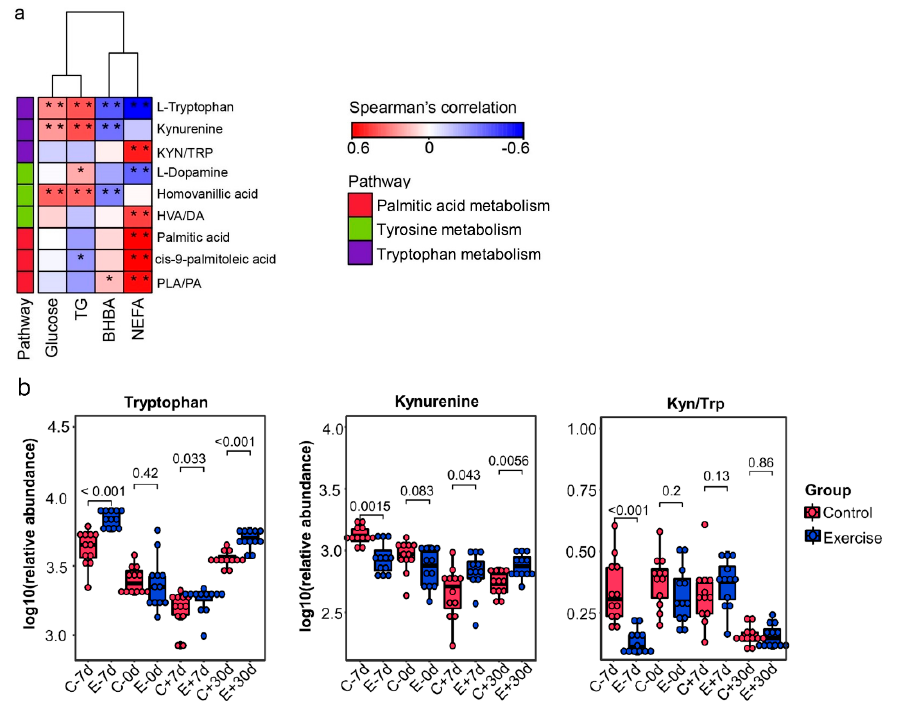
Figure 6. Spearman correlation heatmaps ( a ) for the correlations between phenotypic variables (NEFA, BHBA, TG, and glucose) and key differential metabolites in the exercise and control cows. The scale (right legend) indicates the level of positive (red) or negative (blue) correlations, and asterisks indicate significance: * p < 0.05, ** p < 0.01. PLA/PA = cis-9-palmitoleic acid to palmitic acid ratio; HVA/DA = homovanillic acid to dopamine ratio; Kyn/TRP = kynurenine to tryptophan ratio; NEFA = non-esterified fatty acids; BHBA = β -hydroxybutyric acid; TG = triglyceride. Box plots ( b ) for the relative abundance of tryptophan and kynurenine, and Kyn/Trp in the exercise and control cows at –7 d, 0 d, +7 d, and +30 d relative to calving.